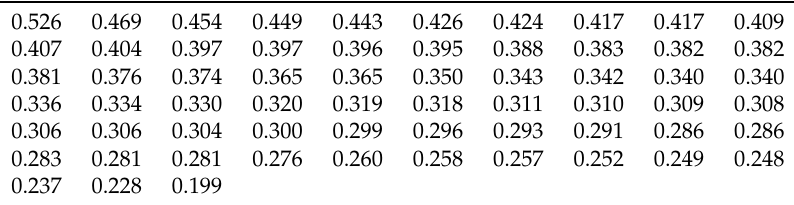
Table 6. Transformed Data Set